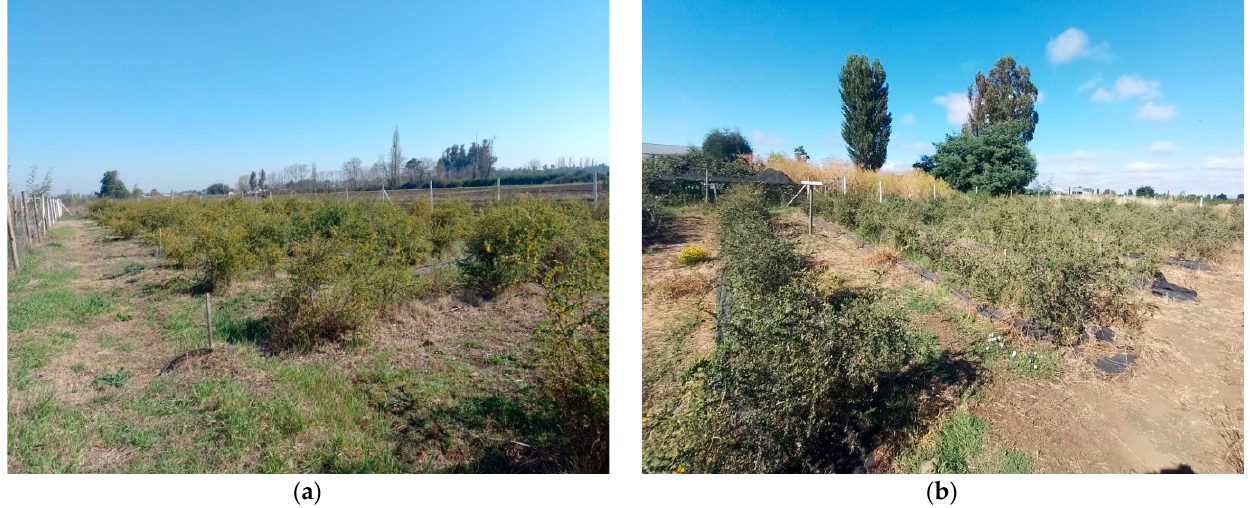
Figure 1. ( a ) Flowering calafate orchard, September 2021. ( b ) calafate orchard in fruiting, December